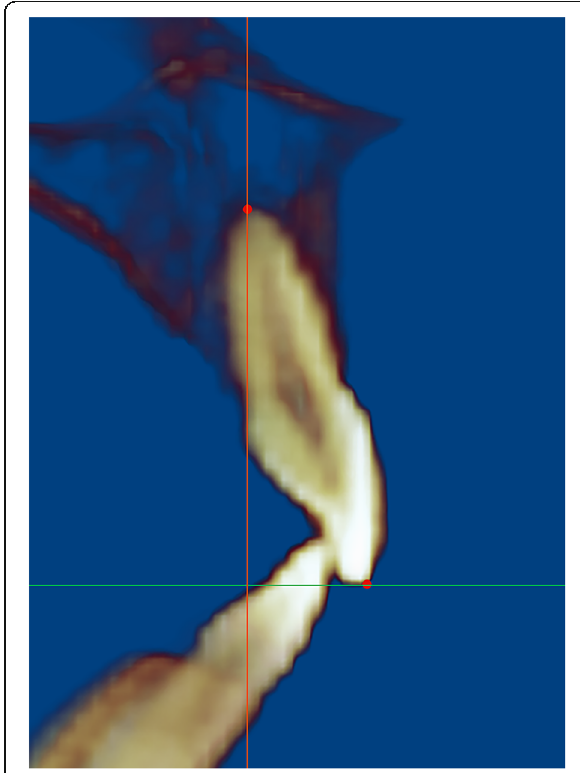
Fig. 2 Measurement of apical root resorption (ARR) on CBCT